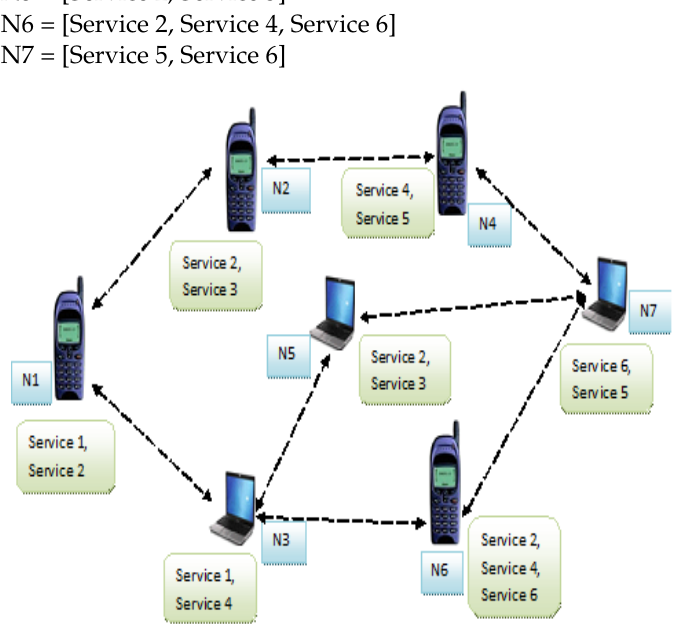
Figure 1. Composite services of mobile nodes.